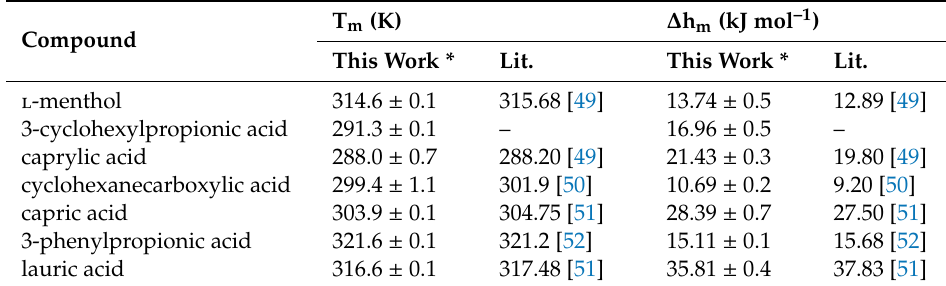
Table 2. Comparison of melting enthalpies ∆ h m and temperatures T m measured in this study and reported in the literature.